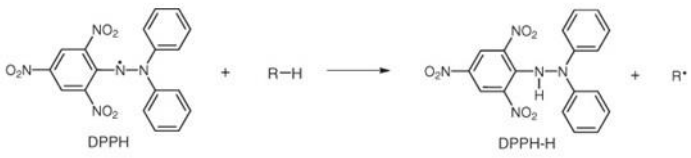
Figure 10. Reaction mechanism of 2,2-diphenyl-1-picrylhydrazyl (DPPH) radical with an antioxidant [52].